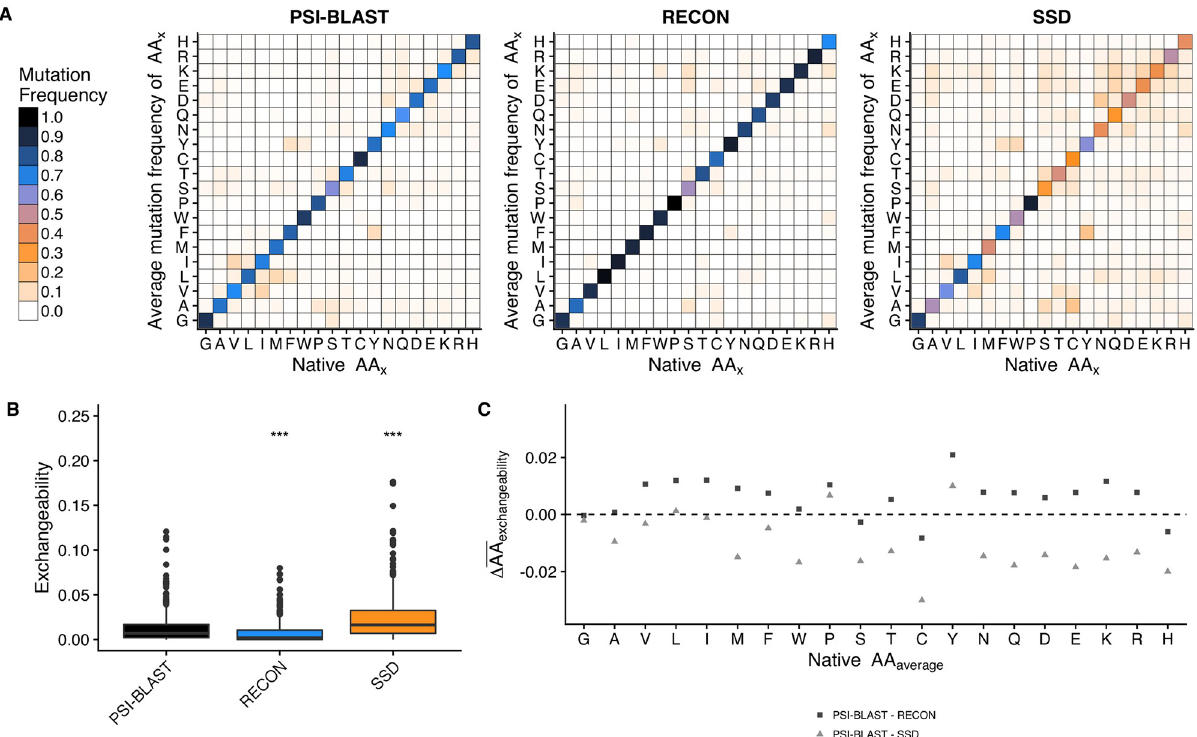
Fig 4. Comparison of exchangeability rates. (A) Average amino acid exchangeability of PSI-BLAST, RECON MSD, and SSD sequence profiles. Single- letter amino acid codes were used for both x and y axes, with the x axis representing the original amino acid and the y axis representing the average mutation frequency the original amino acid to the indicated mutation. (B) Comparison of exchangeability rates between profiles, excluding rates of native sequence conservation rates. The y axis represents the mean frequency a native amino acid is replaced with a specific, non-native amino acid, which we term as amino acid exchangeability. (C) Difference of mean amino acid-specific exchangeability observed in a PSI-BLAST profile compared to a design profile. The x axis represents each type of amino acid present in the native sequence. The y axis represents the difference in average exchangeability frequency of each amino acid type, or rather, the average frequency a native amino acid type is replaced with any other non-native amino acid. A positive value indicates the native amino acid is less likely to be exchanged for a non-native amino acid during design, whereas a negative value indicates the native amino acid is more likely to be exchanged, as compared to a PSI-BLAST